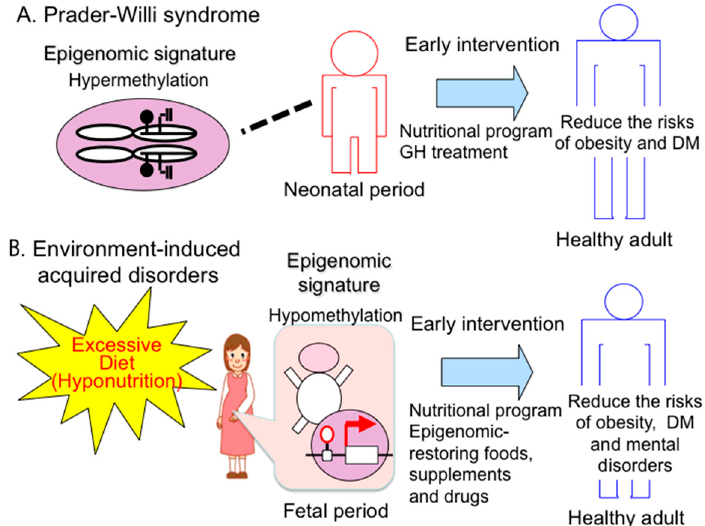
Figure 3. Preemptive medicine in congenital and acquired disorders. ( A ) Prader-Willi syndrome. Early diagnosis based on a specific epigenomic (DNA methylation) pattern has recently enabled early intervention such as an education nutritional program and GH therapy to prevent from expected complications (e.g., obesity, type 2 diabetes mellitus (DM)); ( B ) acquired disorders—early detection of epigenomic changes induced by hyponutrition stress will enable early intervention, such as an education nutritional program and epigenome restarting drugs to prevent expected complications (e.g., obesity, DM).